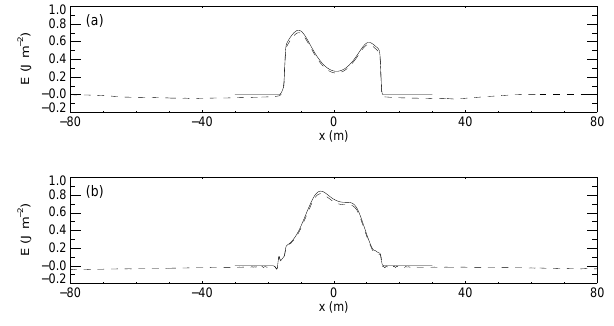
Fig. 19. Vertically integrated energy perturbation, E kp + E a , for the deep seiche cases: comparison of Boussinesq and non-Boussinesq simulations. Solid line: Boussinesq (domain between ± 30m) us- ing ρ 0 = 1000kgm − 3 . Dashed line: non-Boussinesq. (a) t = 20s. (b) t =